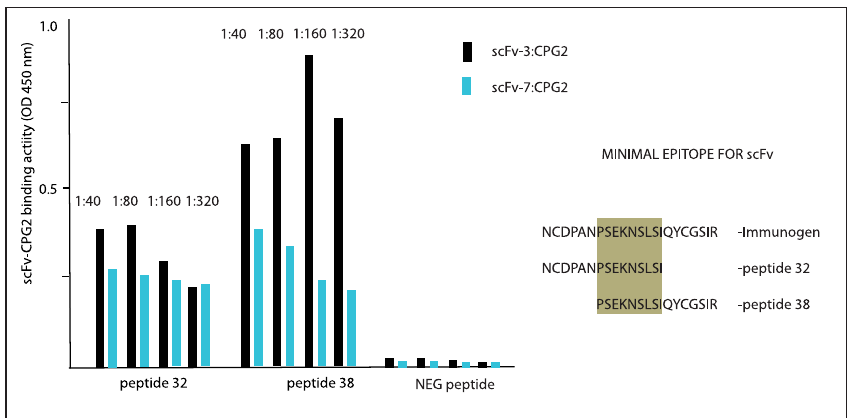
Fig 11. Bioactivity of recombinant scFv-3 and scFv-7 secreted from CHO cells and produced in bacteria as a CPG2-bioconjugate. (A) The indicated scFv (3 or 7) was cloned into pCDNA3.1 containing a leader sequence (amino acids MGGS) for targeted secretion into the media of tissue cultured CHO cells. (i) Binding was measured on left panel after dilution of the supernatants (1:40 or 1:80) to optimize binding against His-tagged CD20 protein; (ii) right panel the optimized supernatants of scFv-3 and scFv-7 were